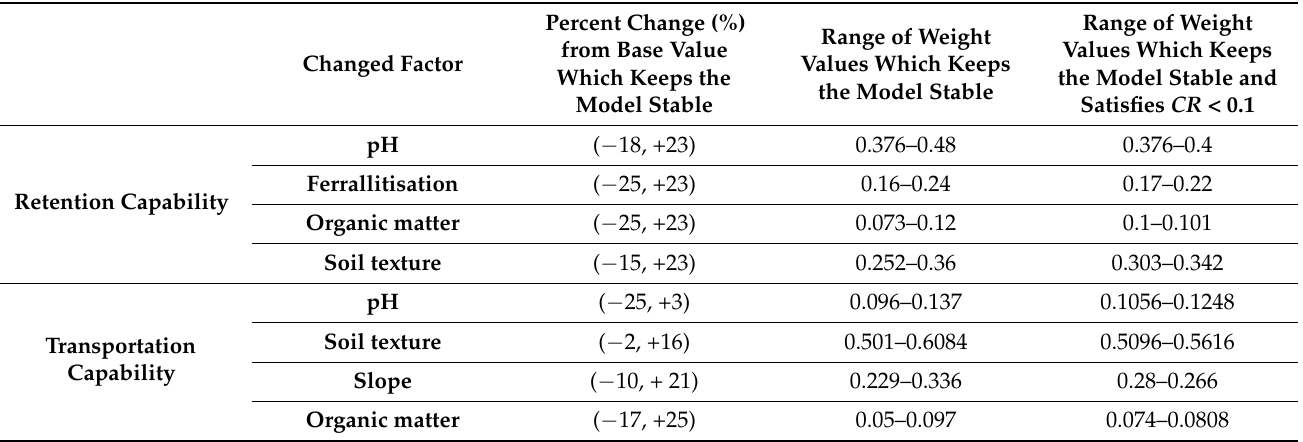
Figure 5. Soil transportation capability: Cell differences compared to the base model. Summary results from 200 simulations (50 runs for each criterion). Factor 1: soil pH, factor 2: soil texture, factor 3: soil slope, factor 4: organic matter. S1: no capability for Al 3+ transport in the soil, S2: little capability, S3: moderate capability, and S4: strong capability. Table 4. Summary of ranges of weight values of each criterion from the 50 sensitivity analysis simulation runs compared to the base